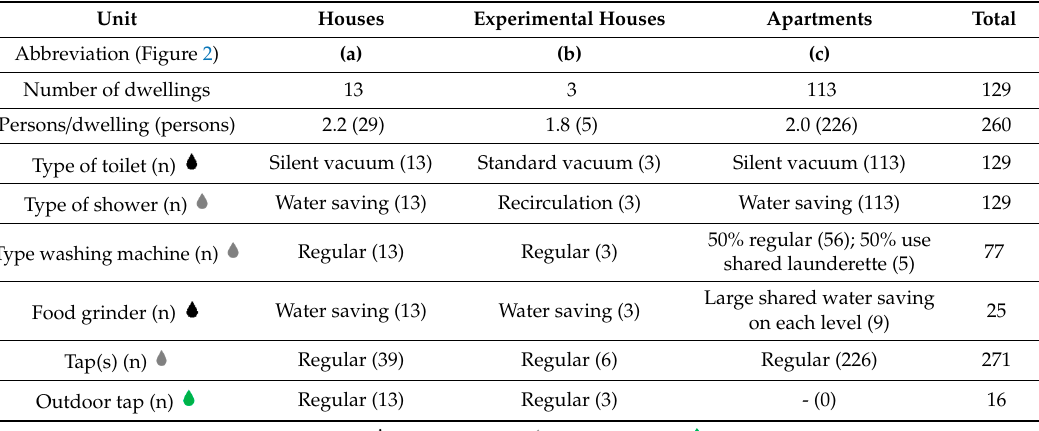
Figure 2. Overview of the case study and household types of SUPERLOCAL. Table 2. The case study and household types of SUPERLOCAL.